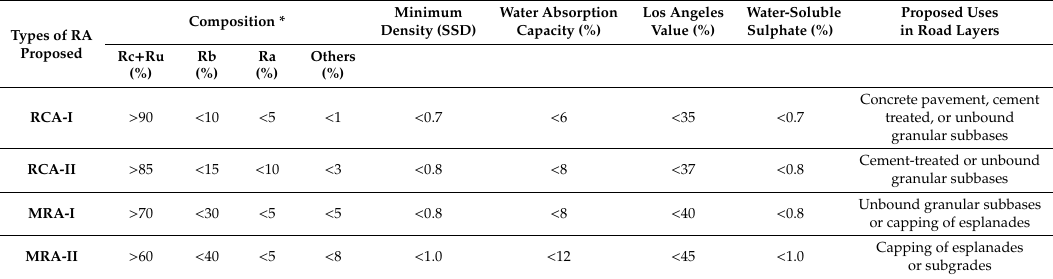
Table 1. Classification of RA proposed for international application in road sections